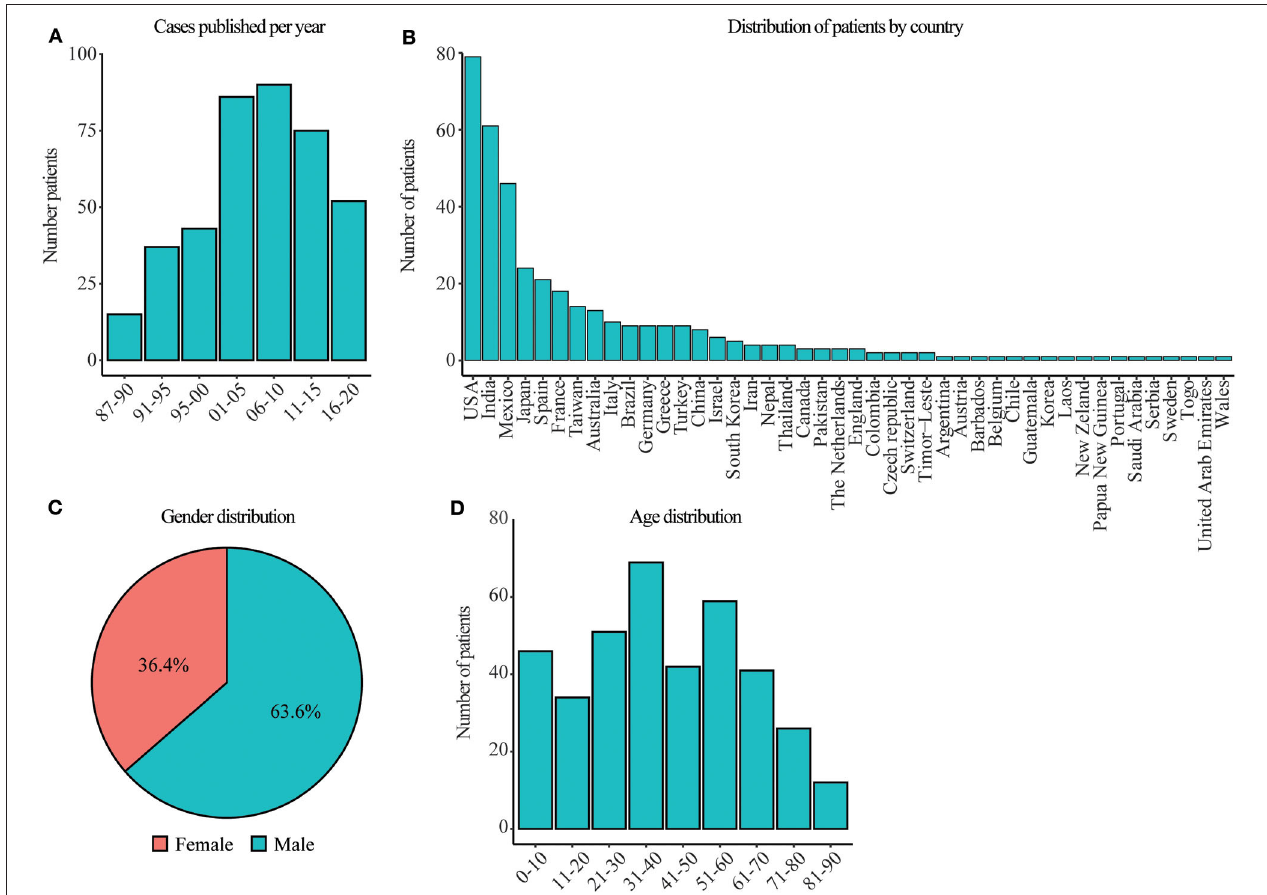
FIGURE 1 | Date, gender, age, and geographical distribution of patients with isolated nocardiosis. (A) Year of publication of patients with isolated nocardiosis since 1987. Around 2010 the number of case series published increased in detriment of individual case reports. In most of those case series, we could not extract the data from individual patients so we excluded them from our analysis. Therefore, the number of cases continuously increases with time despite the graph shows a decrease after 2010. (B) Countries where patients from A were reported. (C) Gender distribution of patients with isolated nocardiosis. (D) Age distribution of patients with isolated nocardiosis published since 1987. The information for these figures was obtained from the references (